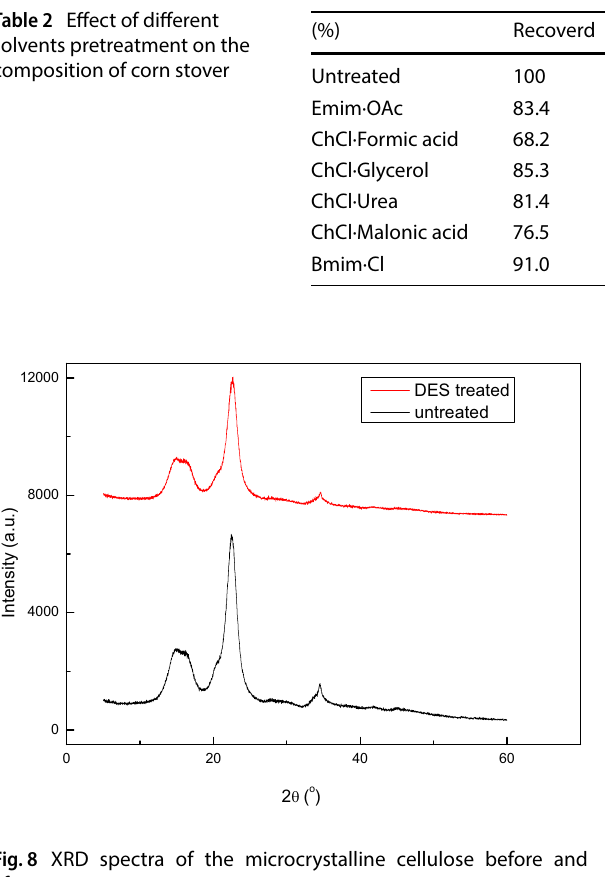
Fig. 8 XRD spectra of the microcrystalline cellulose before and after pretreatment